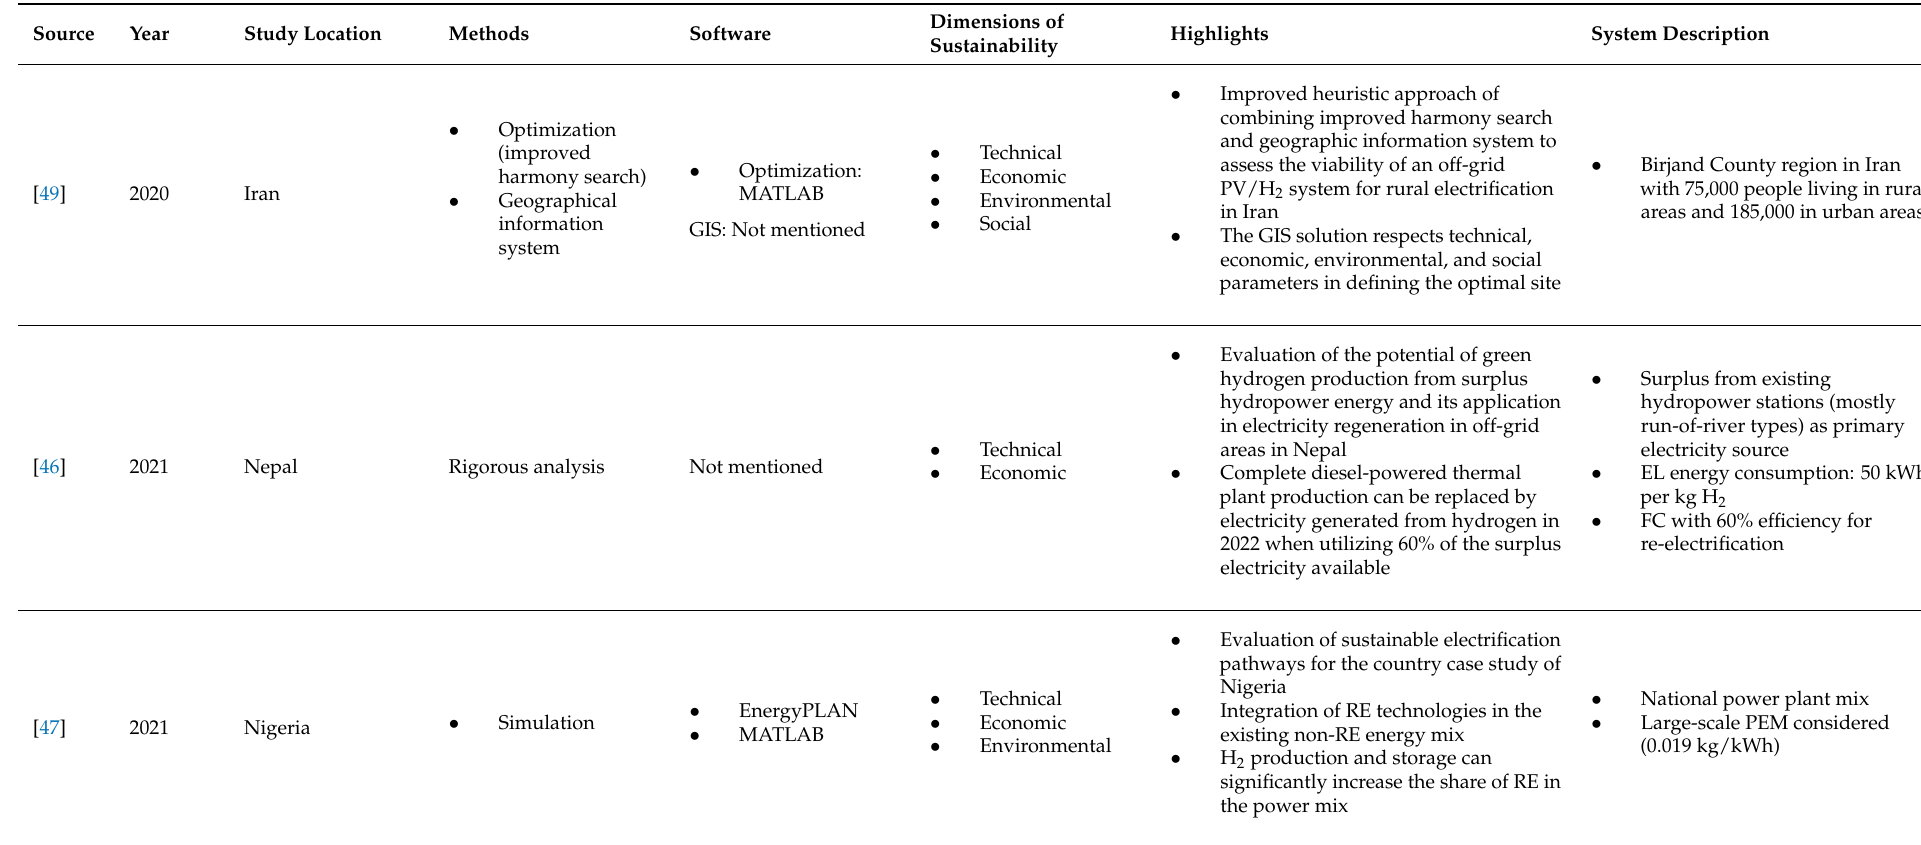
Table 6. Variables of interest for the literature considering hydrogen applications for power supply with large-scale hydrogen production or large-scale power